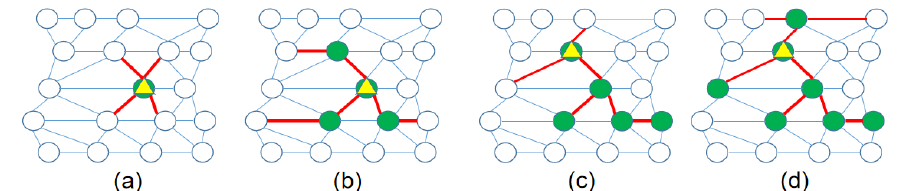
Figure 7. ( a ) The green node is the current node (yellow triangle), search for the connected nodes (red straight line) of the upper and lower adjacent channels (excluding this channel). ( b ) If it meets the requirements, it will be classified as the same category, search for only a node on both sides (red straight line), so far, the current node has been processed. ( c ) Update the current node (yellow triangle), and search again for the nodes connected by the upper and lower adjacent channels. ( d ) Search for only one node on both sides again (red